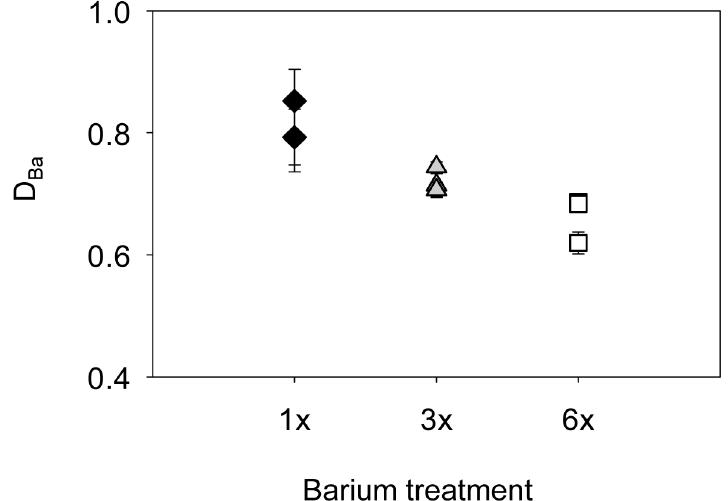
Figure 5. Influence of barium treatment on elemental partitioning. Mean ± standard error of barium partition coefficients (D by barium treatment. Black diamonds represent 1x, grey triangles 3x, and unfilled squares 6x that of average local barium values.